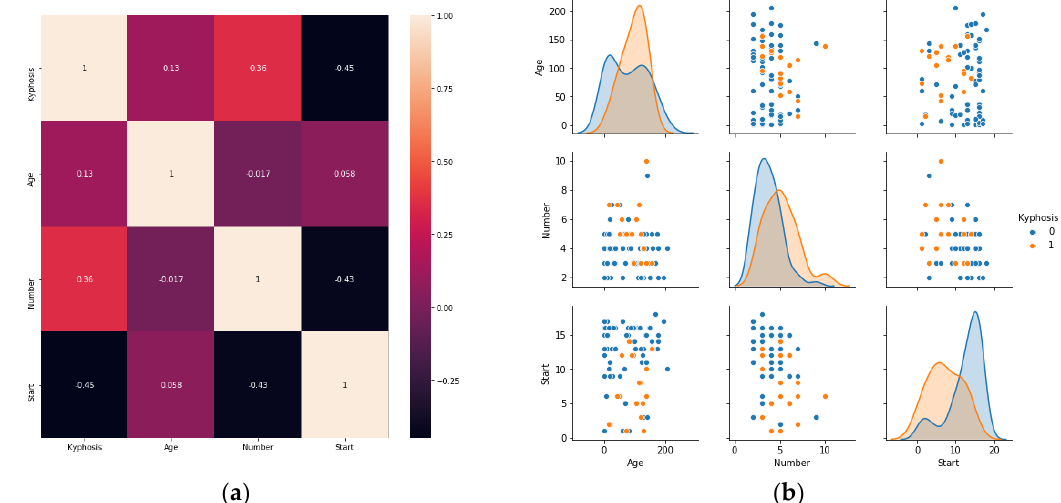
Figure 11. The distribution of the kyphosis disease representing absent or present.